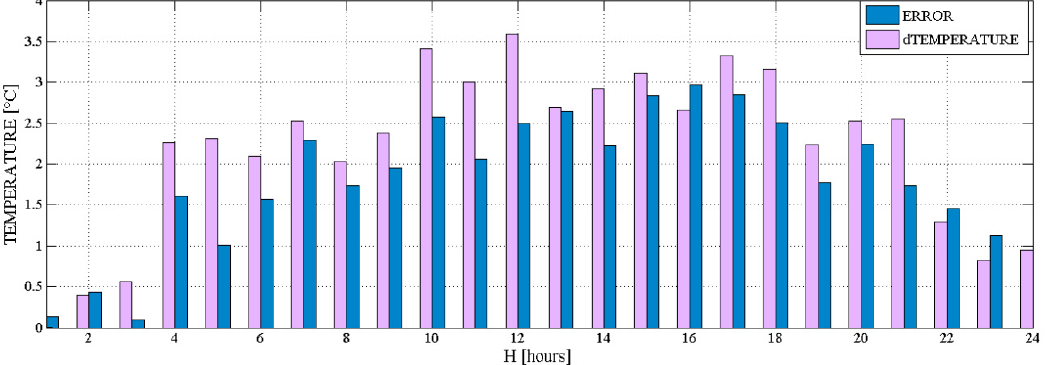
Figure 6. NNARX performance.